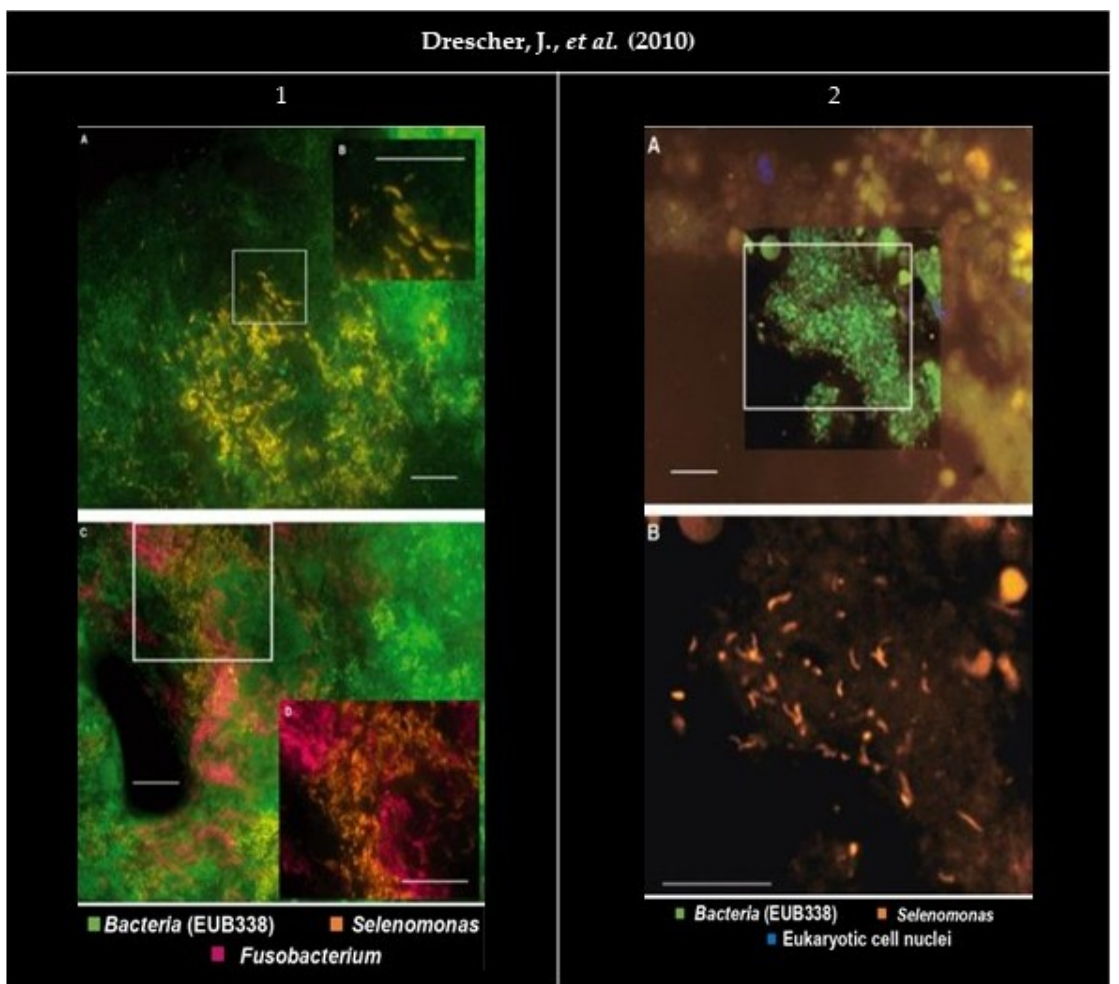
Figure 2. Panel of the gathered images. ( 1A , C ) Organisms stained by the probe SELE appear as densely packed groups in the cervical portion of the subgingival biofilm. ( 1B ) Higher magnification shows a crescent-shaped morphology. ( 1C , D ) EUB338 FITC (Fluorescein isothiocyanate) (green), SELE Cy3 (Cyanine 3) (bright orange) and FUSO Cy5 (Cyanine 5) (magenta). ( 1D ) Higher magnification, with EUB338 FITC filter removed for better interpretation. Bars indicate 10 µm. ( 2 ) FISH (Fluorescence in situ hybridization) performed on a gingival biopsy. ( 2A ) EUB338 FITC (green), SELE Cy3 (orange), and eukaryotic cell nuclei stained with DAPI (4′, 6-diamino-2-phenylindole) (blue). ( 2B ) Higher magnification took with the Cy3 filter set only. Bars indicate 10 µm. All images were reprinted and adapted with the publisher’s permission.